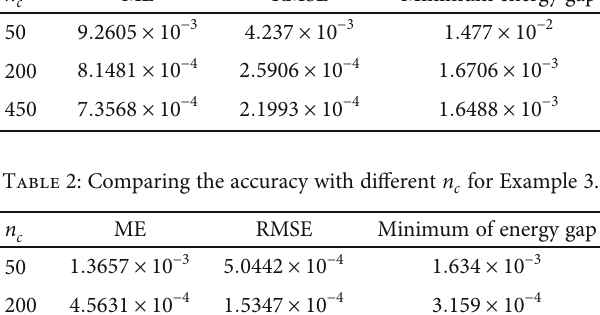
for Example 2. c